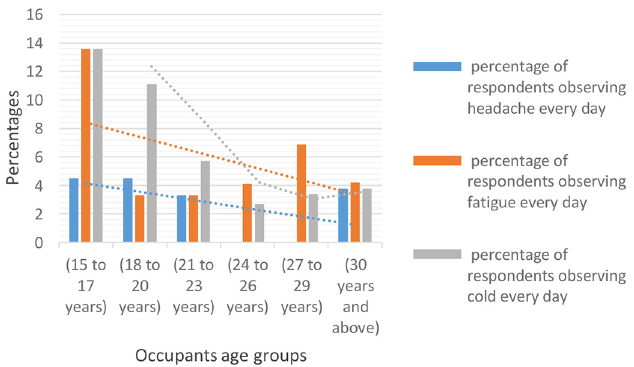
Fig. 10. Relationship between observance of health symptoms and occupants